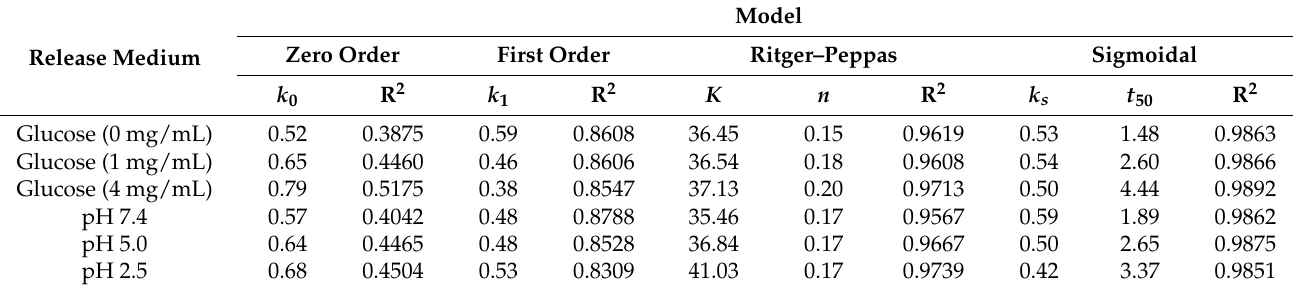
Table 1. Mathematic modeling of insulin release.